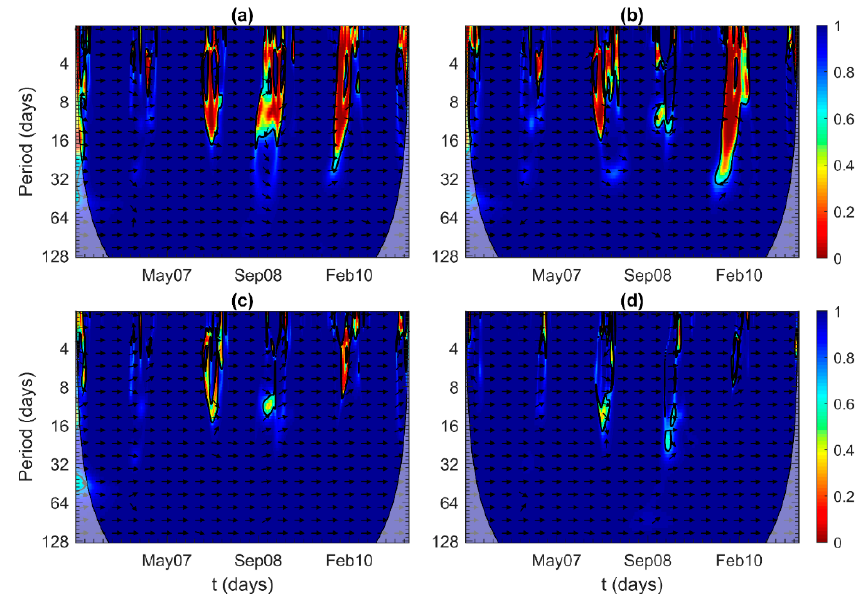
Figure 4. Dissimilarity in the time-scale domain between pre and post parameter adjusted streamflow signals are shown with the Wavelet Transform Coherence (WTC). The cone of influence is represented using a lighter shade (region where edge effects become dominant). The abscissa is time and the ordinate is the wavelet scale equivalent to the Fourier period. The coherence value is encoded by color. The thick black contour lines represent the 5% significance level against red noise. The phase relationship between the pre- and post-adjusted streamflow signals is indicated with arrows, with right arrows representing a in-phase relationship; left, a anti-phase relationship, down a pre-adjusted signal leading post-adjusted signal by 90 ◦ and up post-adjusted signal leading pre-adjusted signal by 90 ◦ . Phase relationship is only shown where coherence is ≥ 0.5. WTC for four commonly adjusted SWAT parameters to achieve calibration are shown, where ( a ) is TIMP, ( b ) is snowfall temperature ( ◦ C) (SFTMP), ( c ) is melt factor for snow on 21 June (mm H 2 O/ ◦ C-day) (SMFMX) and melt factor for snow on 21 December (mm H 2 O/ ◦ C-day) (SMFMN) and ( d ) is frozen soil infiltration factor (CN_FROZ). Change of streamflow shown in the time-scale domain resulting from one-at-a-time parameter adjustment. All four parameters are considered as pure calibration parameters in this